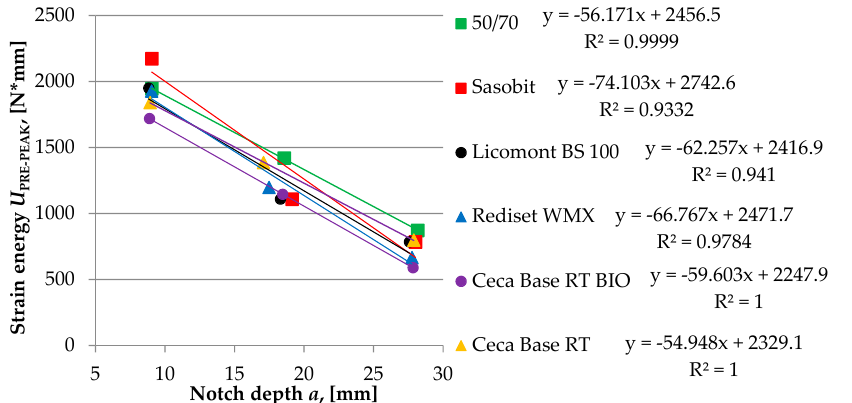
Figure 12. The graphical explanation of J C calculation from the SCB test at − 20 °C. Table 5. SCB test results at 10 °C.